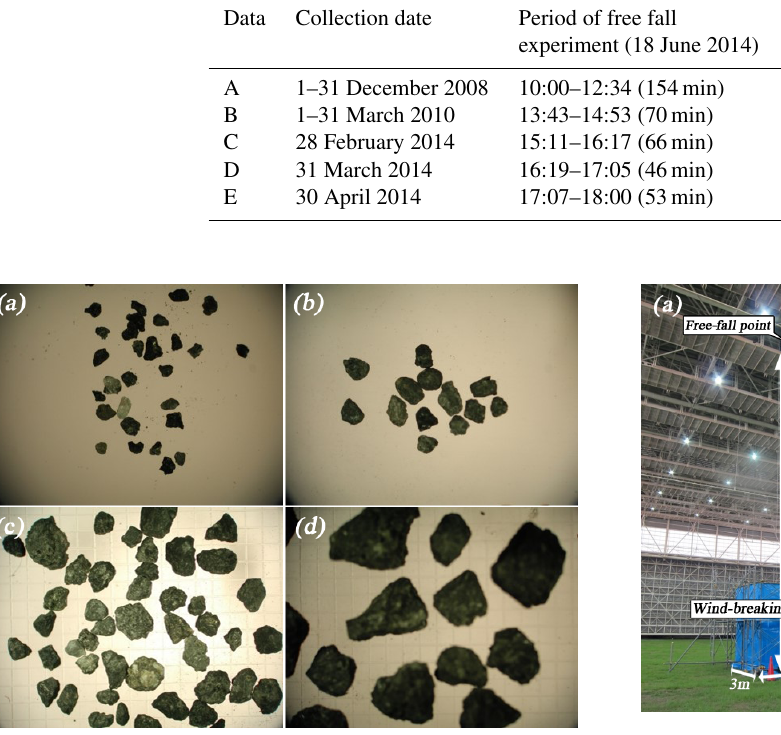
Figure 5. Free-fall experiment conditions of volcanic ash particles on the (a) outside and (b) inside of the wind-breaking wall cover- ing the disdrometers in the large-scale rainfall simulator of the Na- tional Research Institute for Earth Science and Disaster Prevention